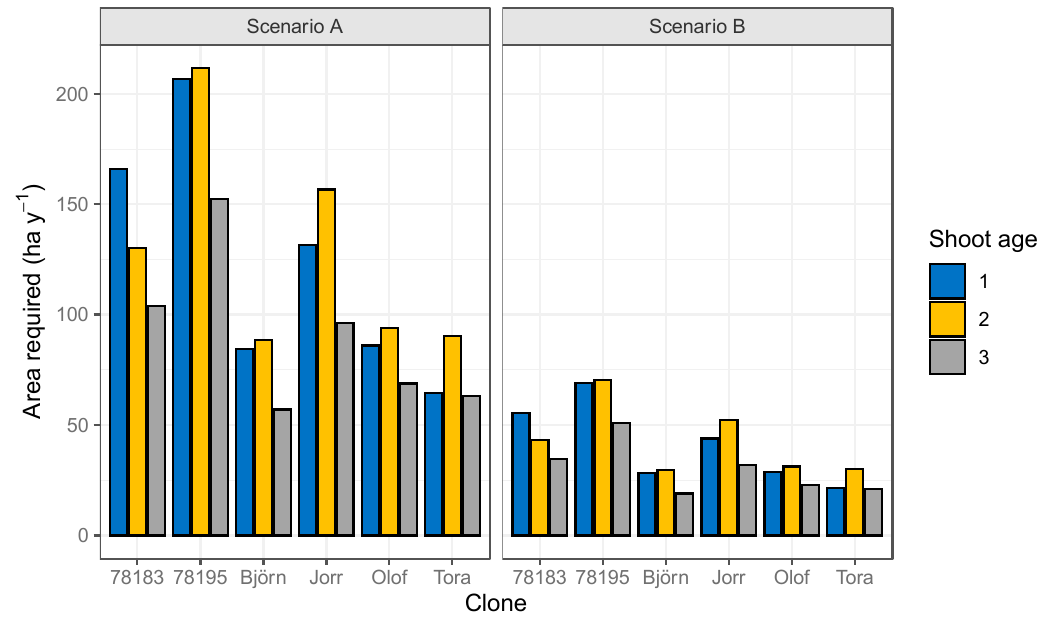
Figure 6. Area required for supplying Salix biomass to a 1000 m 3 co-digestion digester at 3 kg m − 3 OLR with 50% Salix VS (Scenario A), and 2 kg m − 3 OLR with 25% Salix VS (Scenario B). Shoot age refers to the age of the above-ground biomass at harvest.